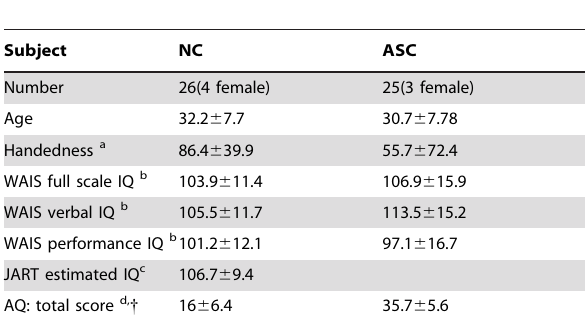
Table 1. Demographic data and rating scale